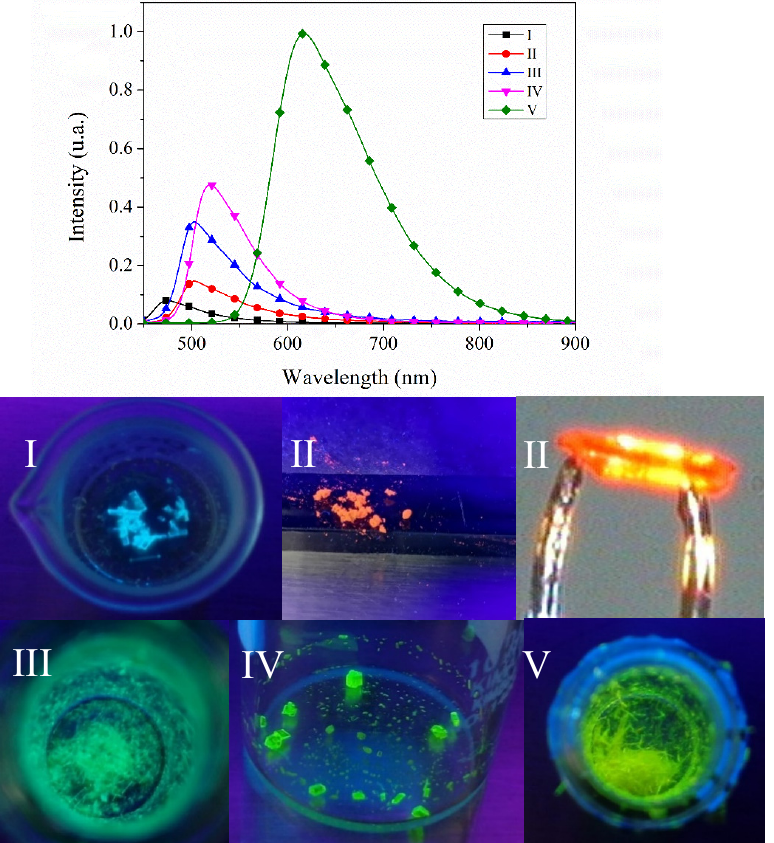
Figure 10. Emission spectra of compounds I – V and images of the crystals under UV lamp.